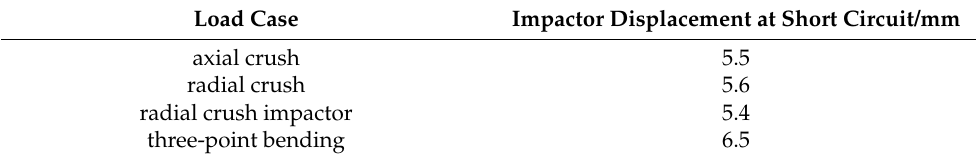
Table 3. Impactor displacement at the occurrence of a short circuit for four tested cell-load